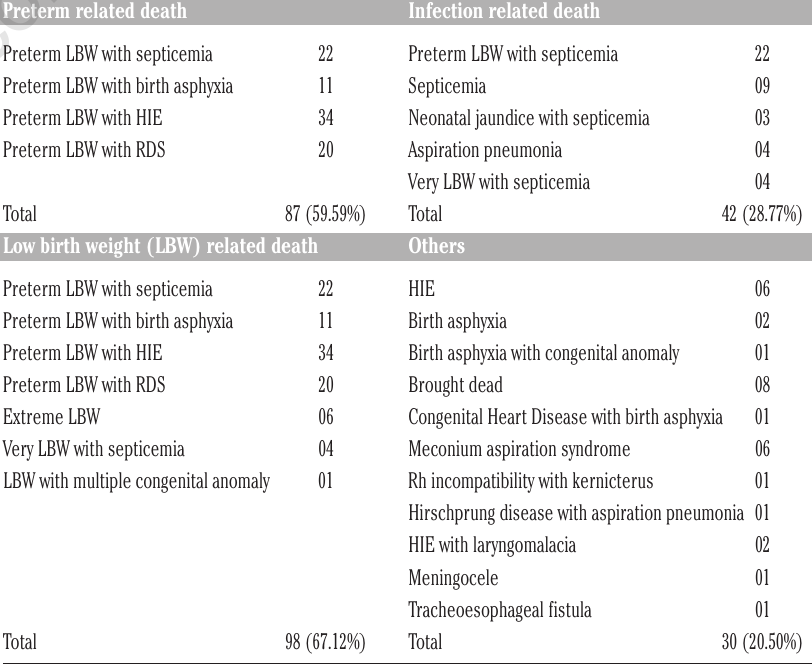
Table 1. Pattern of neonatal deaths (Total neonatal deaths,